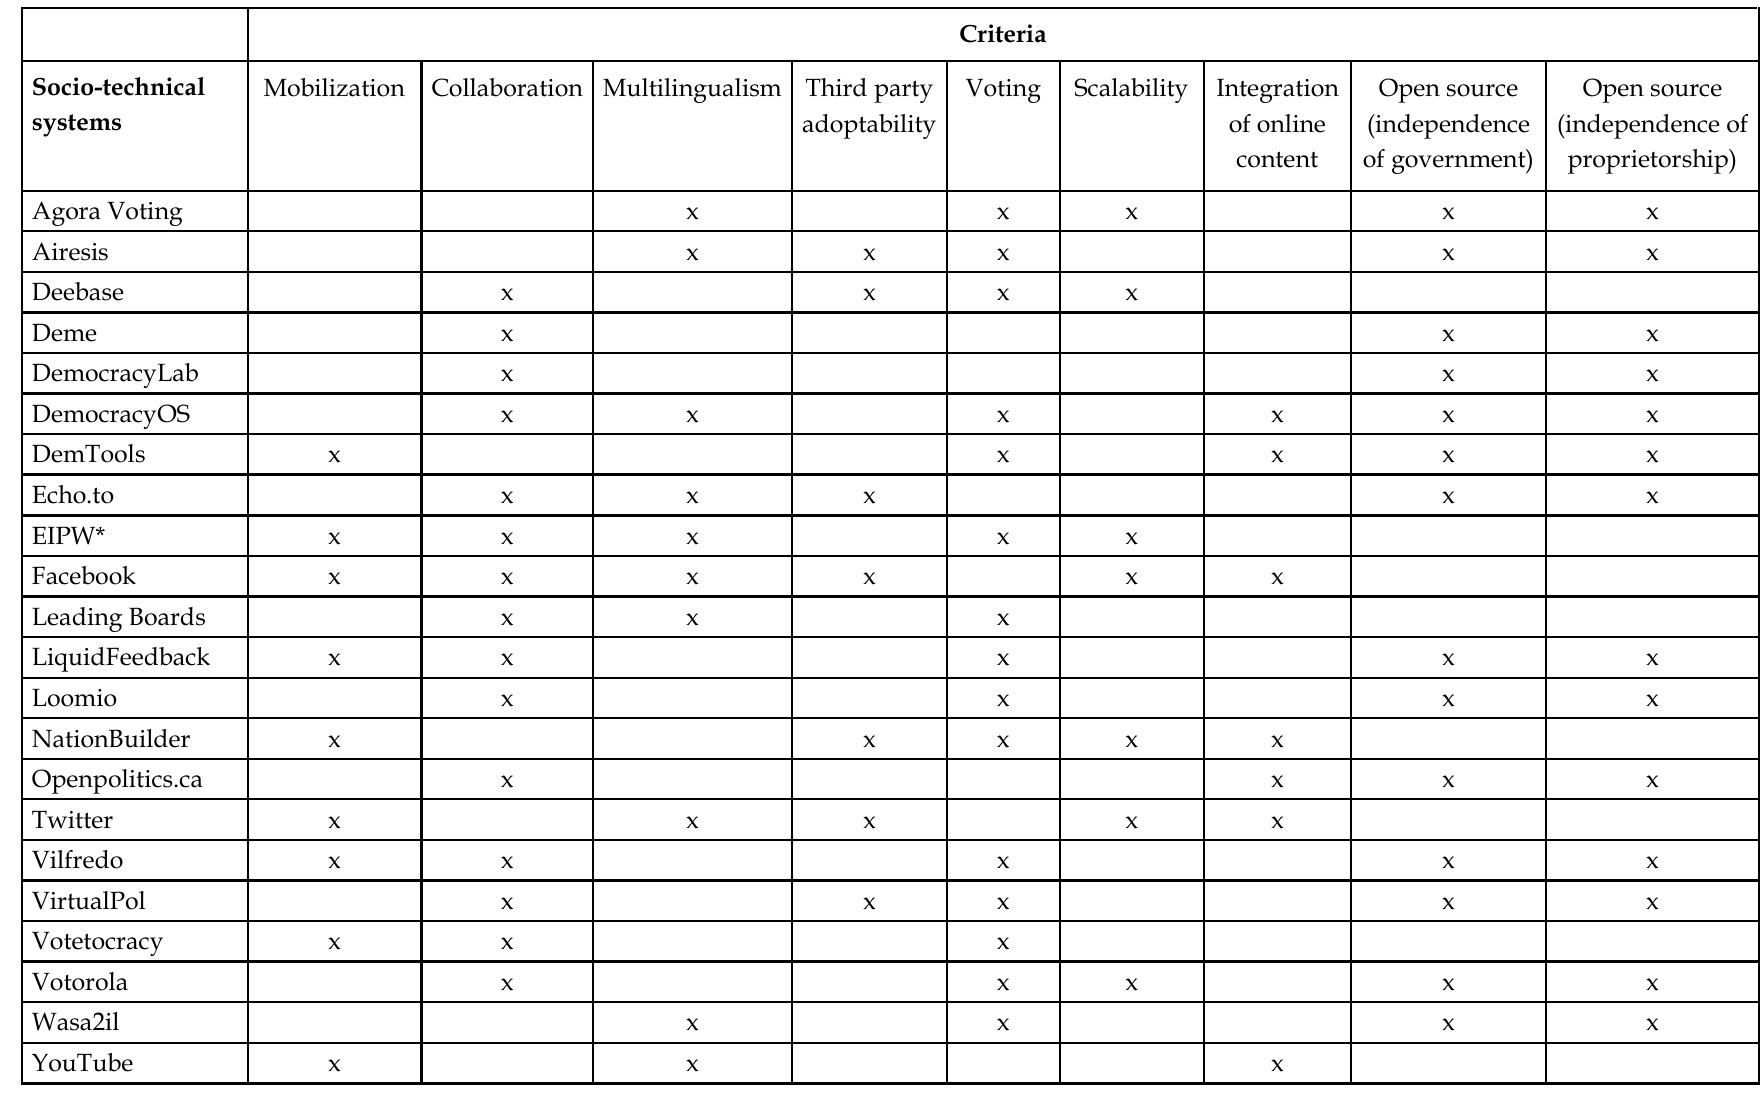
Table 1: Comparison matrix of socio-technical systems for democratic engagement. Asterisk (*) refers to Electronic Infrastructure for Political